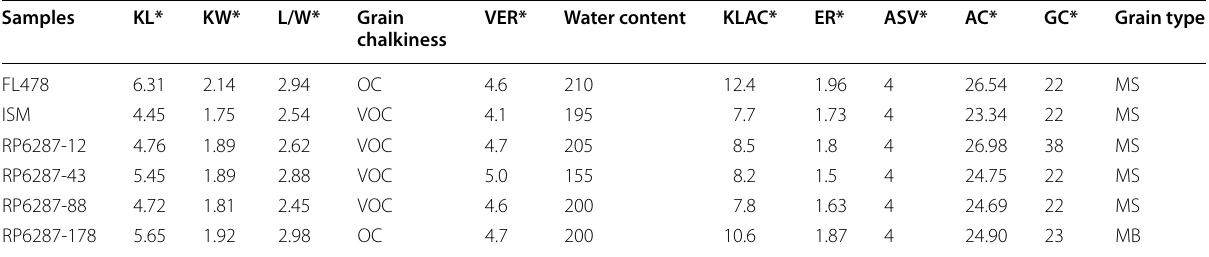
Table 3 Analysis of grain size and cooking quality characters of the parents and four improved lines of ISM